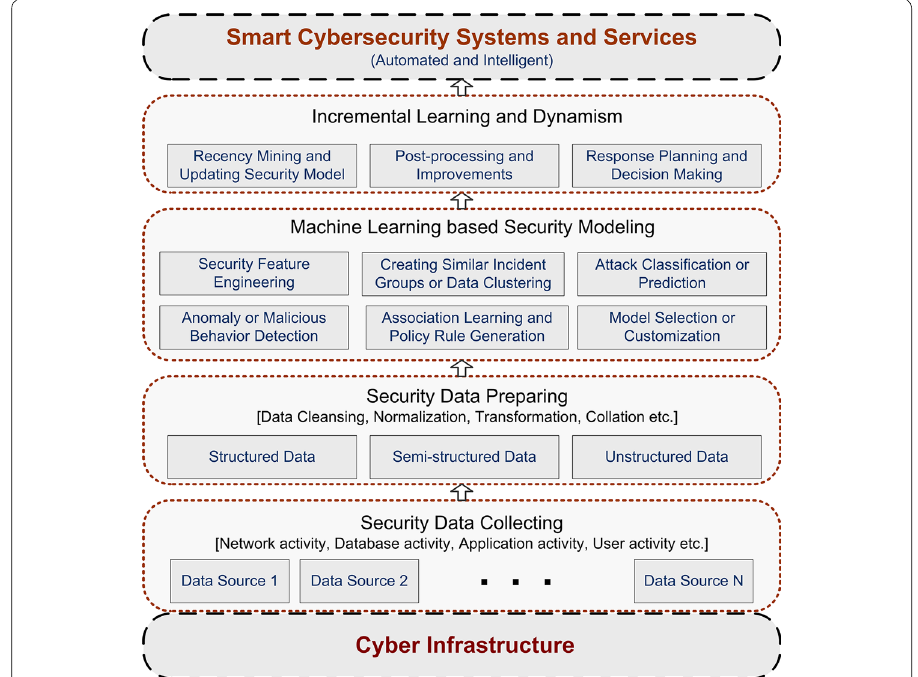
Fig. 3 A generic multi-layered framework based on machine learning techniques for smart cybersecurity